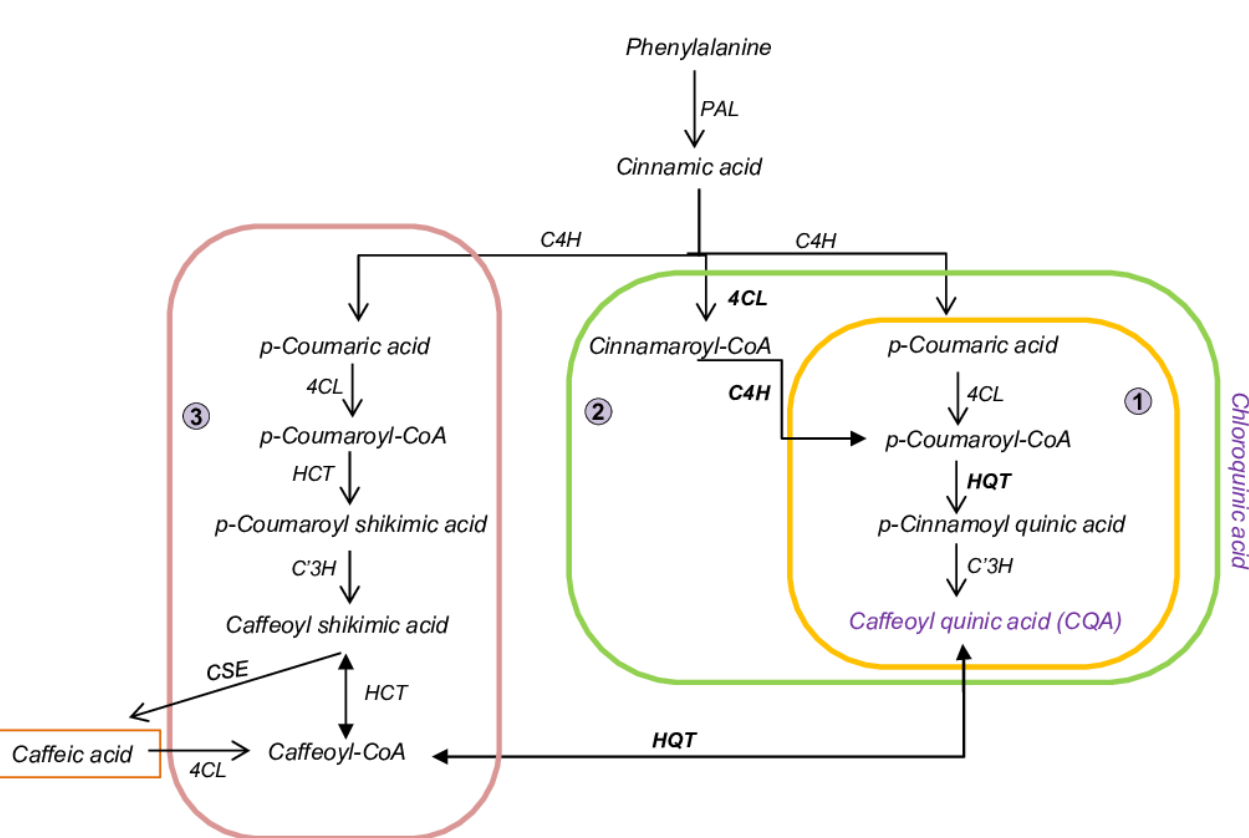
Figure 1. Schematic diagram of phenylalanine towards to caffeoylquinic acid (CQA) biosynthesis in A. spathulifolius . 1, 2, and 3 indicate the different route pathways of chlorogenic acid production. PAL , phenylalanine ammonia-lyase; C4H , cinnamic acid 4-hydroxylase; 4CL , 4- coumarate--CoA ligase; C3 ′ H , p-coumarate 3 ′ Hydroxylases; CSE , caffeoylshikimate esterase. HCT , hydroxycinnamoyl CoA shikimate hydroxycinnamoyl-transferase; HQT , hydroxycinnamoyl CoA quinate hydroxycinnamoyl-transferase.